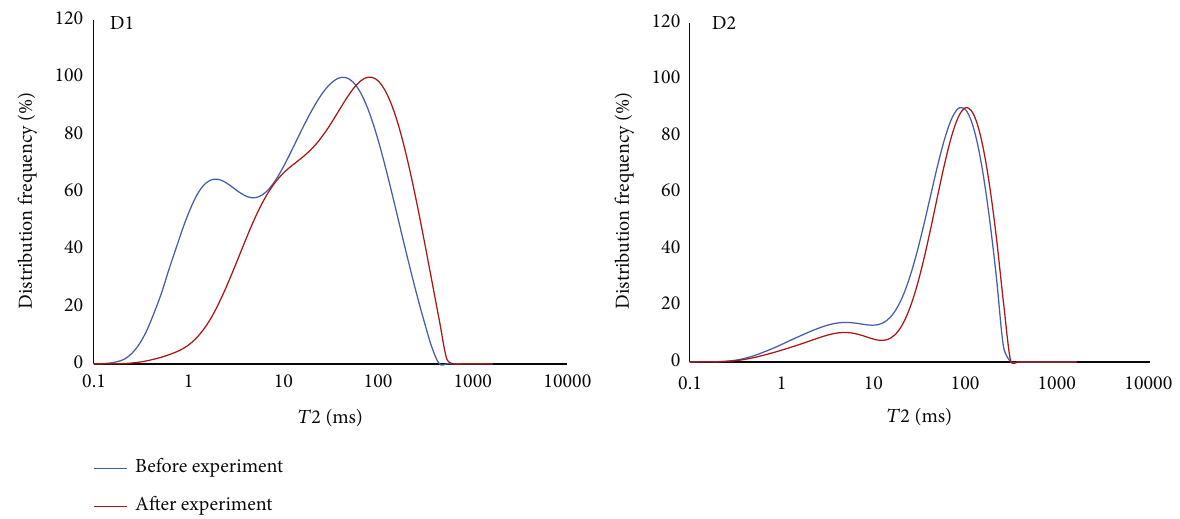
Figure 8: Contrast fi gure of nuclear magnetic resonance curves before and after core velocity-sensitive experiment.